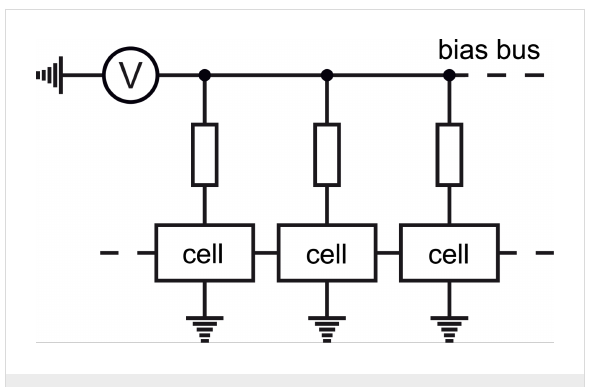
Figure 4: RSFQ power supply